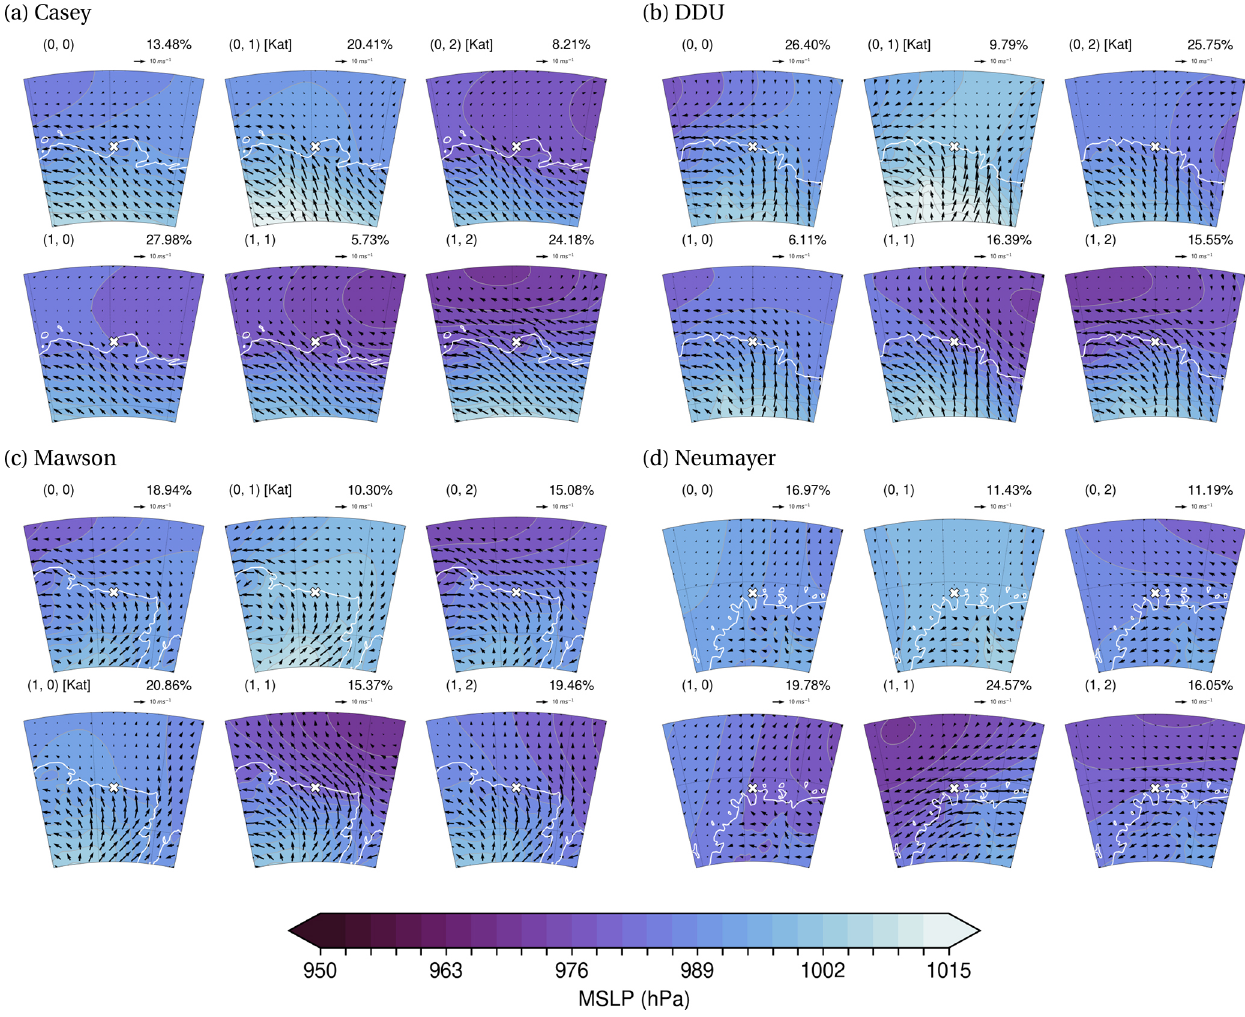
Figure 5. Composited ERA5 mean sea-level pressure (MSLP) with 10m wind vectors for each node at (a) Casey, (b) DDU, (c) Mawson and (d) Neumayer from SOMs calculated for the period 2010–2017. Station locations are marked as a white cross. Nodes with limited synoptic forcing but favourable conditions for katabatic forcing are labelled with a